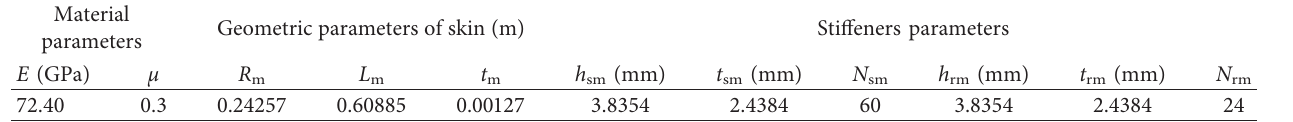
Note. t -skin thickness, h r and h s -height of rectangular stiffeners, t r and t s -thickness of rectangular stiffeners, and N r and N s -number of stiffeners.